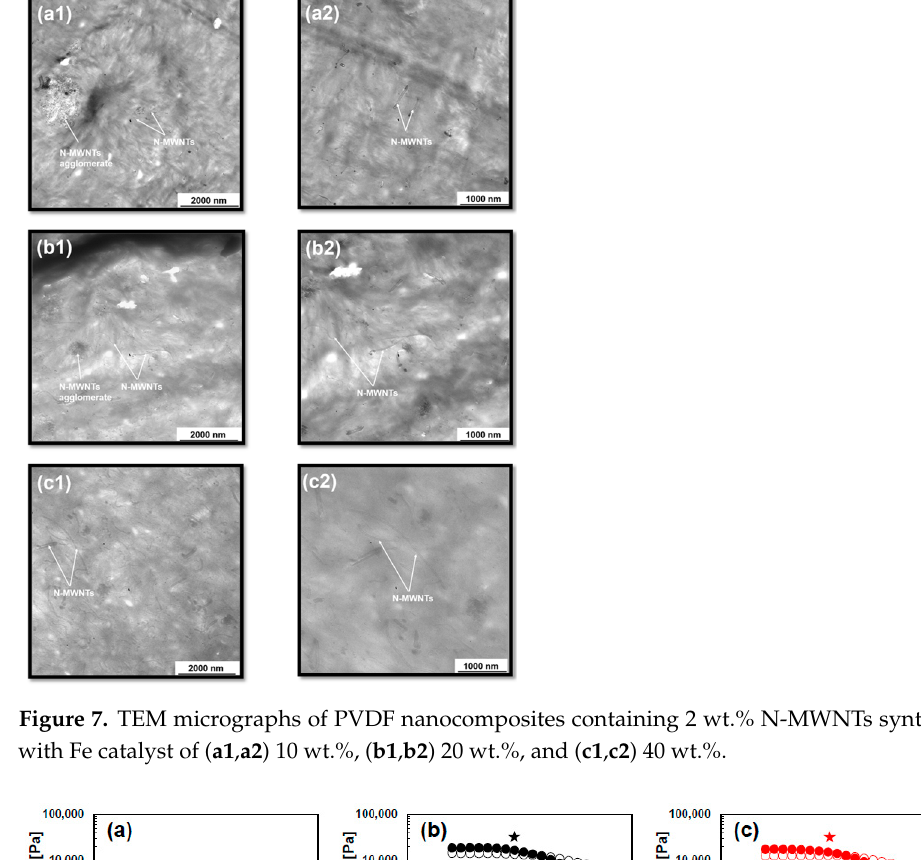
11 of 20 Figure 6. LM images of microtomed N-MWNTs/PVDF nanocomposites with 2.0 wt.% N-MWNTs synthesized at various catalyst concentration, ( a ) 10 wt.%, ( b ) 20 wt.%, ( c ) 40 wt.%, ( d ) Agglomerate area ratio of thin cuts of 2.0 wt.% N-MWNTs/PVDF nanocomposites.